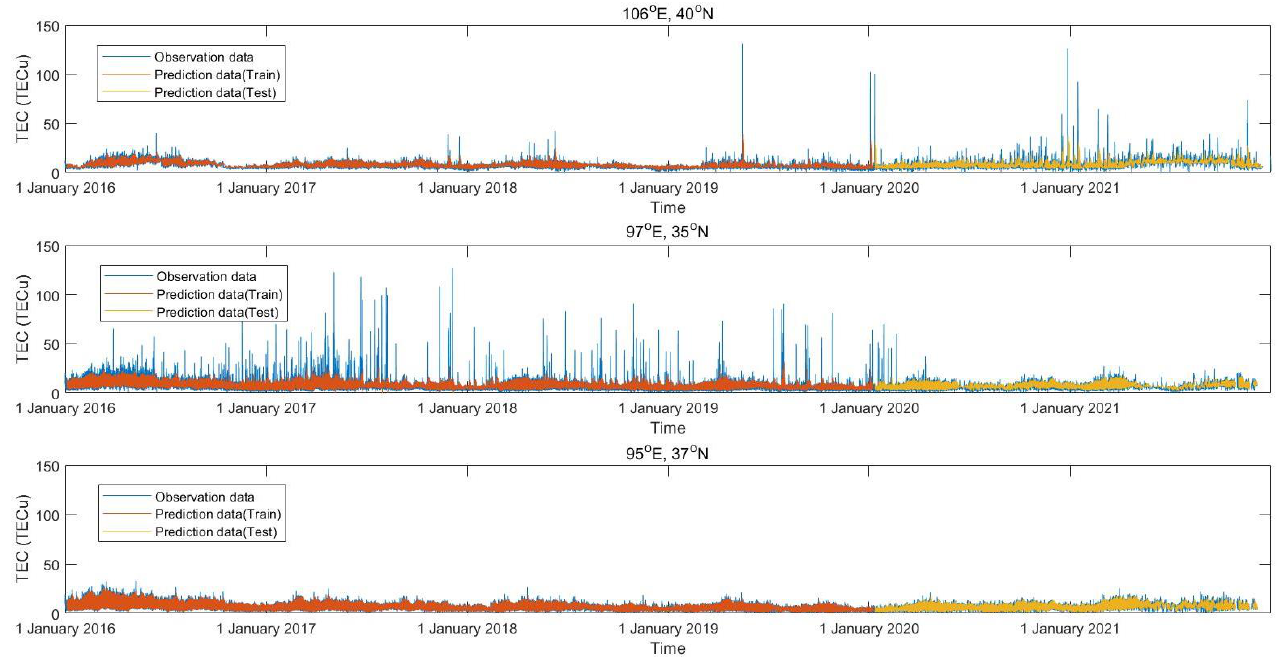
Table 2. The train RMSE and test RMSE at three positions.